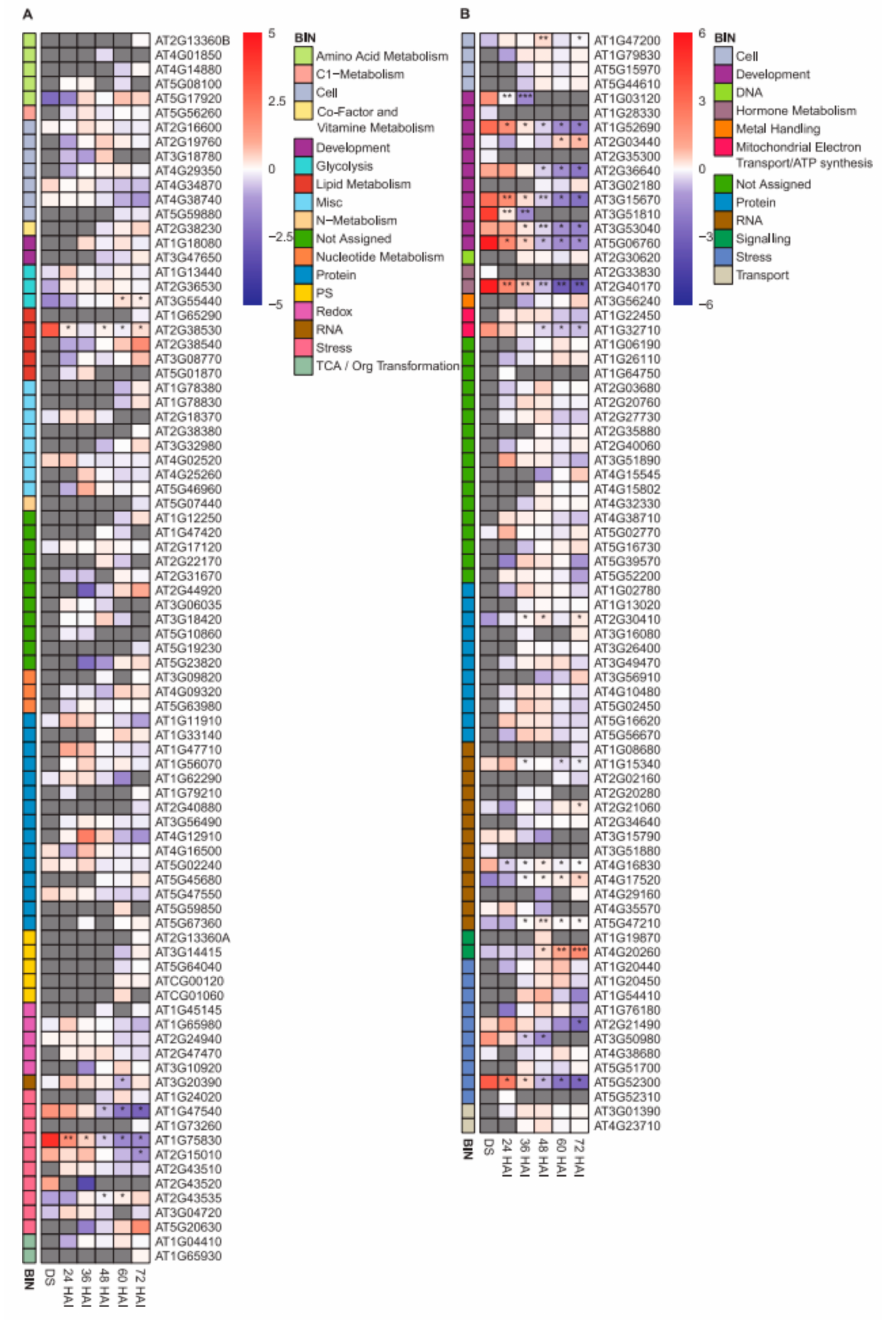
Figure 5. Abundance of proteins with ( A ) 0% and ( B ) 100% disorder content in the heat-stable proteome in dry seeds (DS), germinating seeds and seedlings. The color gradient represents the log 2 -median transformed means of mass spectral LFQ intensities ( n = 3). Gray boxes represent missing values at the indicated time point. Levels of significance comparing protein abundance in germinating seeds and seedlings to DS (unpaired two-sided t -test) are indicated by asterisks (* p < 0.05; ** p < 0.01; *** p < 0.001). Proteins are assigned to MapMan bins, each bin is indicated by a unique color as shown. The transcript AT2G13360 mapped to two bins and was therefore marked with A and B. For additional information, see Supplemental Table